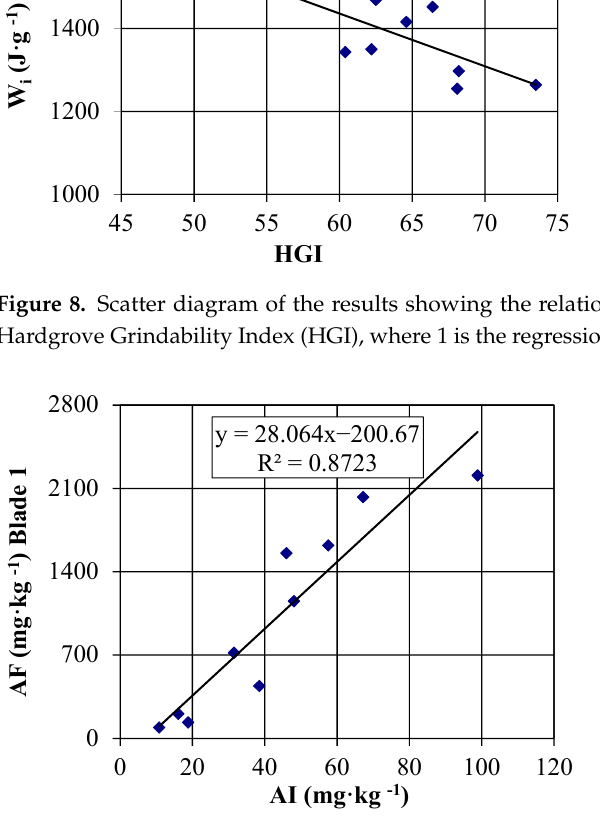
Figure 9. Scatter diagram of results showing the relationship between Abrasion Factor (AF) and Abrasion Index (AI), where 1 is regression line AF upon AI (R 2 = 0.8723).